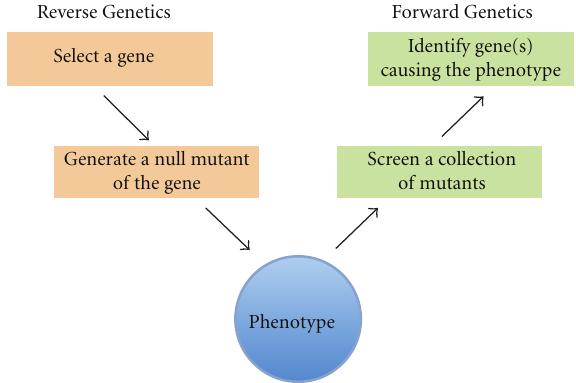
Figure 1: A schematic representation of forward and reverse genetic approaches for genetic association of phenotypes. Reverse genetics starts with the selection of gene of interest and culminates with the phenotypic analysis of its disruption. Forward genetics starts by selecting a phenotype of interest and ends in identifying gene(s) responsible for that